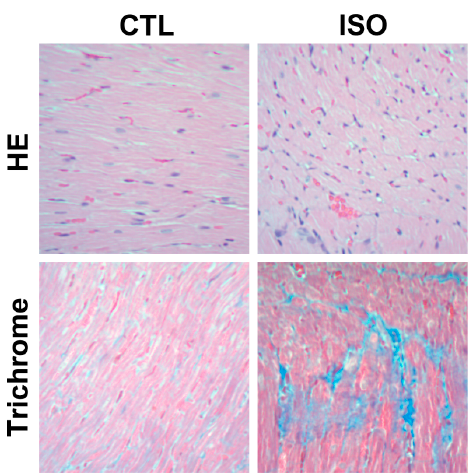
Figure 6. Representative HE- and trichrome-stained heart sections of rats under 200x magnification. CTL = control; HE = hematoxylin and eosin; ISO = isoproterenol.